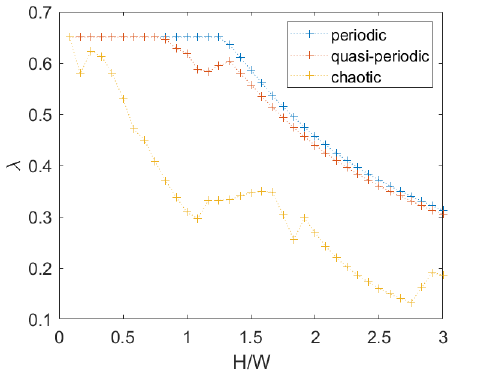
Figure 13. Comparison of failure multiplier at q = 0 for different textures (averaging the response to left- and right-oriented forces for quasi-periodic and chaotic